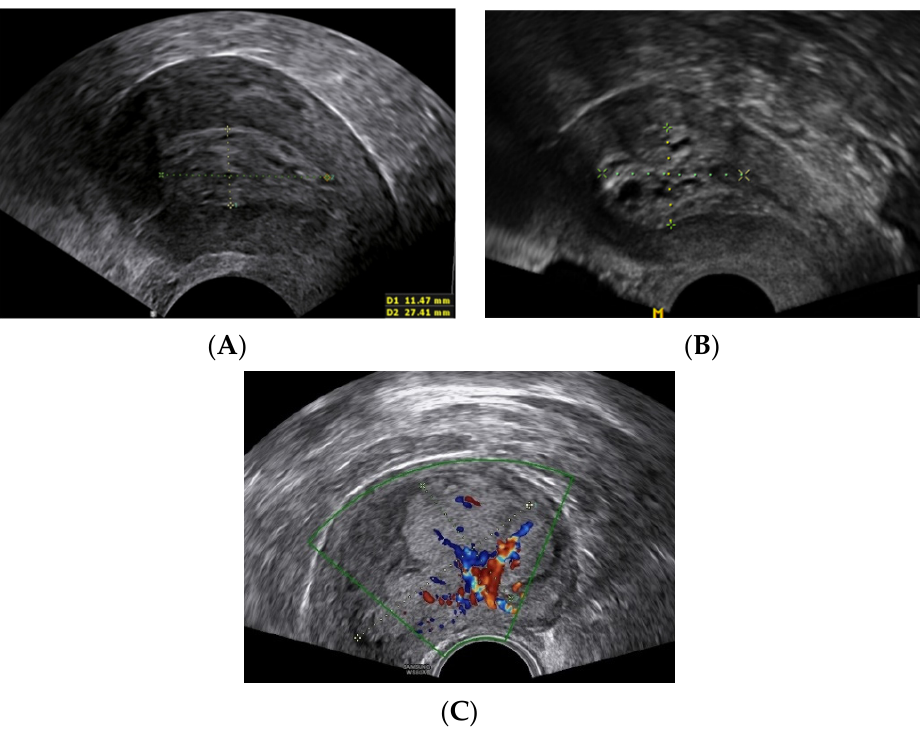
Figure 1. Tumor ultrasound characteristics. ( A ) No myometrial invasion; ( B ) myometrial invasion <½; ( C ) myometrial invasion >½.